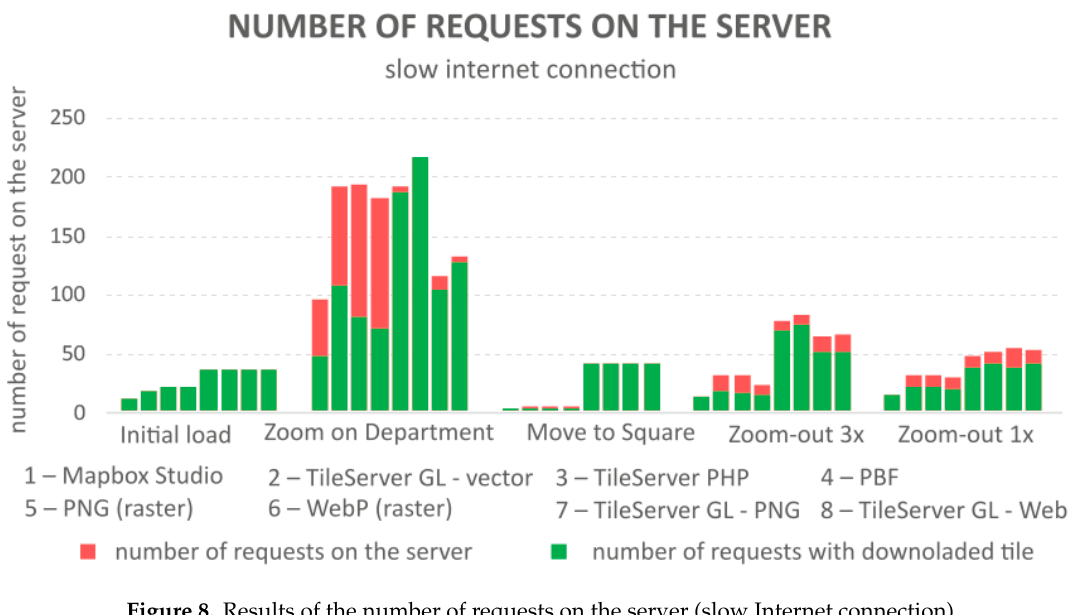
Figure 8. Results of the number of requests on the server (slow Internet connection).